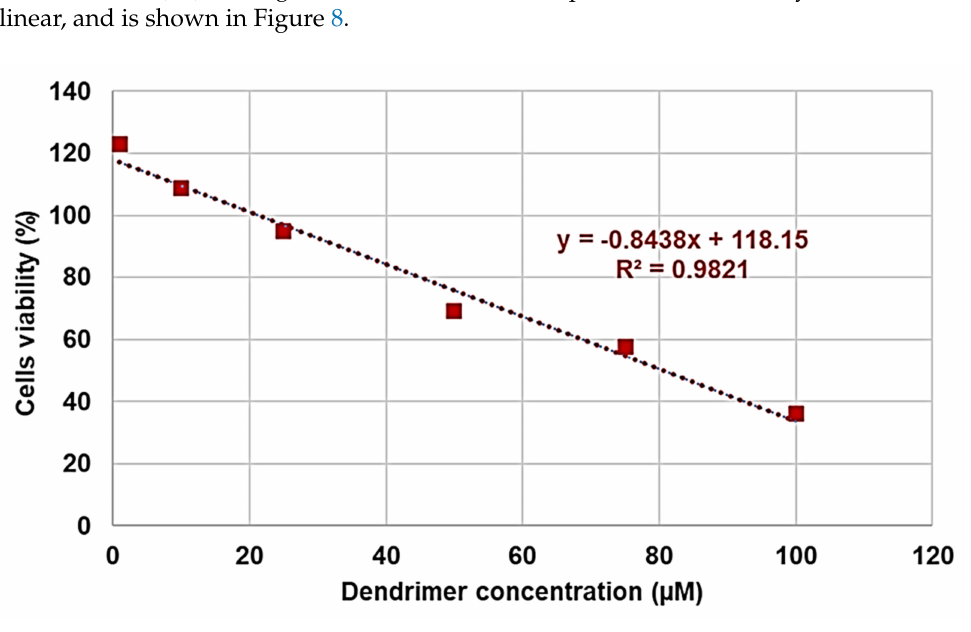
Figure 8. Linear regression model obtained from data relating to 24 h of cells